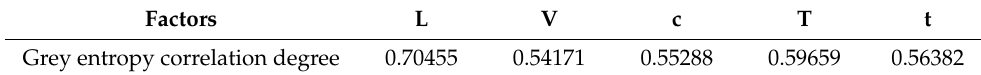
Table 6. Grey entropy correlation degree of each correlation